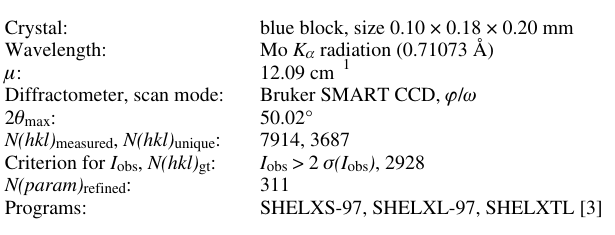
Table 1. Data collection and handling.